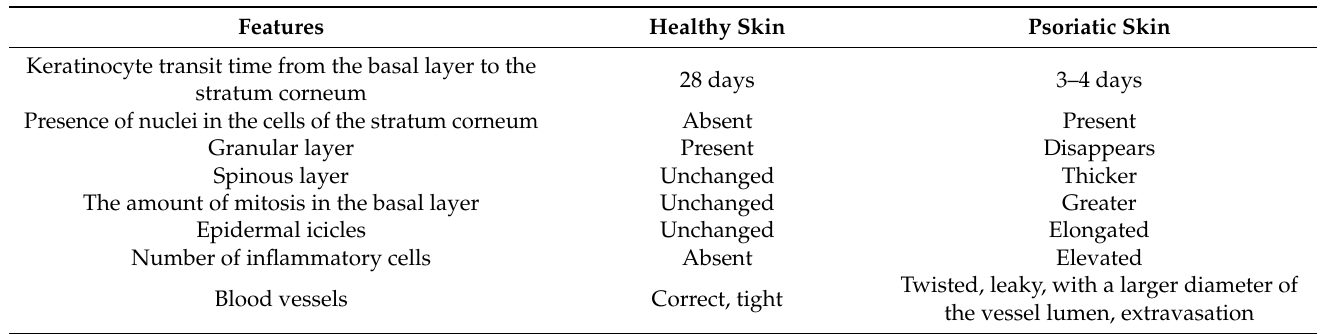
Table 1. List of skin lesions in psoriasis.